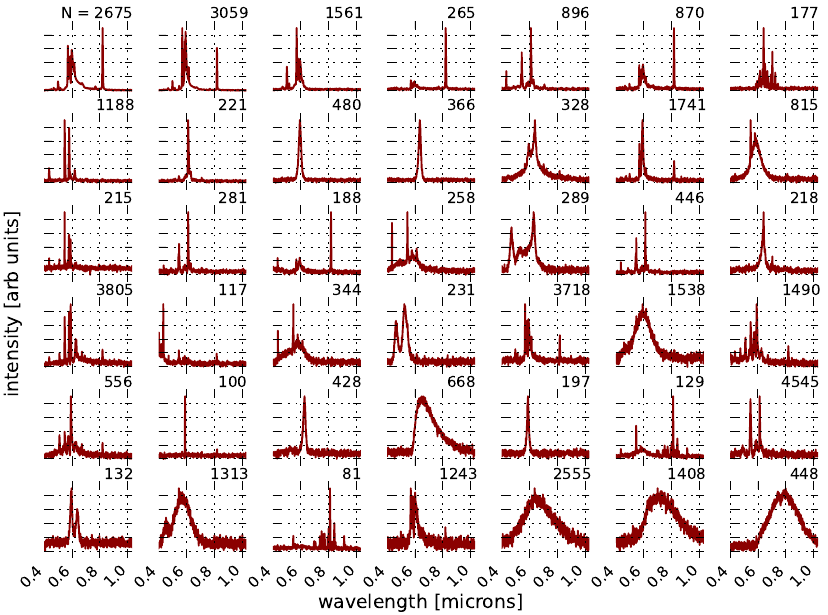
Figure 17. The results of performing template-activated partition clustering (see Figure 11 and Section 4.2.2) on our dataset to identify all statistically-robust observed lighting types. The methods of clustering used were k -means, DBSCAN and hierarchical.